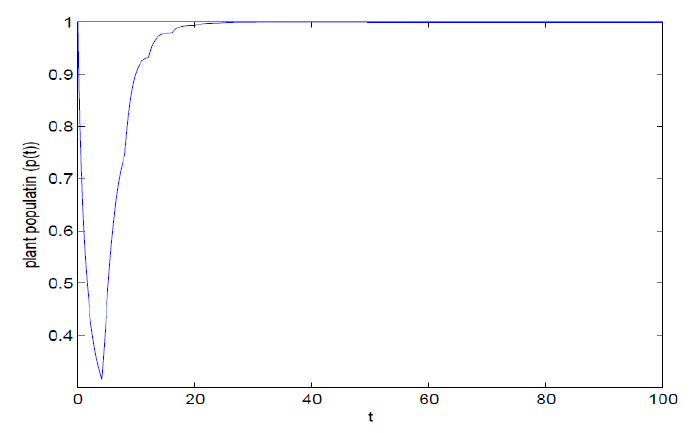
Figure 13. Plant population (𝑝(𝑡)) is stable for 𝜇